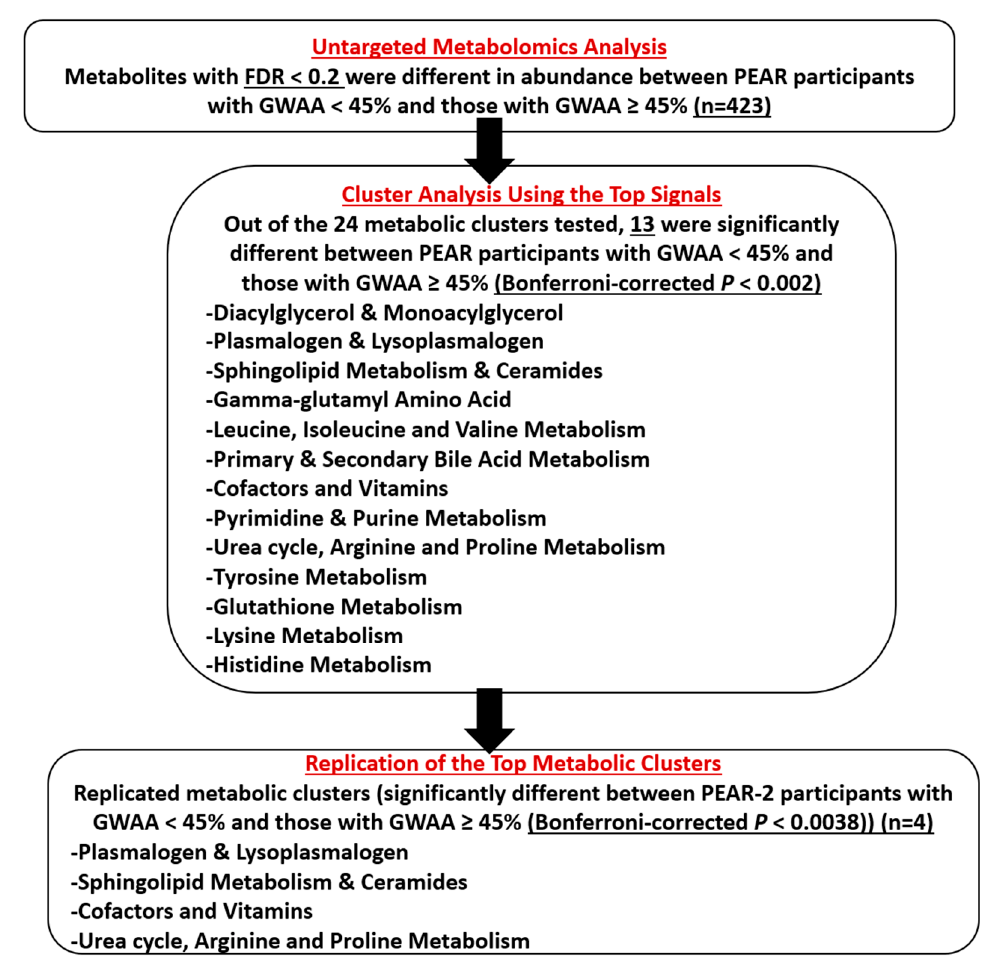
Figure 1. Chart showing the flow of the study results. Abbreviations: FDR, false discovery rate; PEAR, Pharmacogenomic Evaluation of Antihypertensive Responses; GWAA, African ancestry.